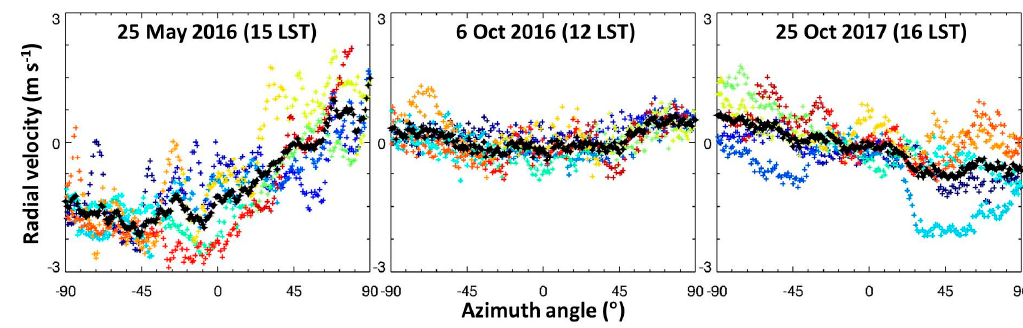
Figure 4. Examples of angular distribution of radial velocity from the third gate (approximately 200 m altitude) observed by the wind Doppler lidar during the 15 min after the start of the radiosonde flight. The colored points indicate the initial VAD scan with each color indicating the minute during which the data point was measured (i.e., data points with the same color were measured during the same minute). The black points indicate the 15-min-averaged VAD scan.